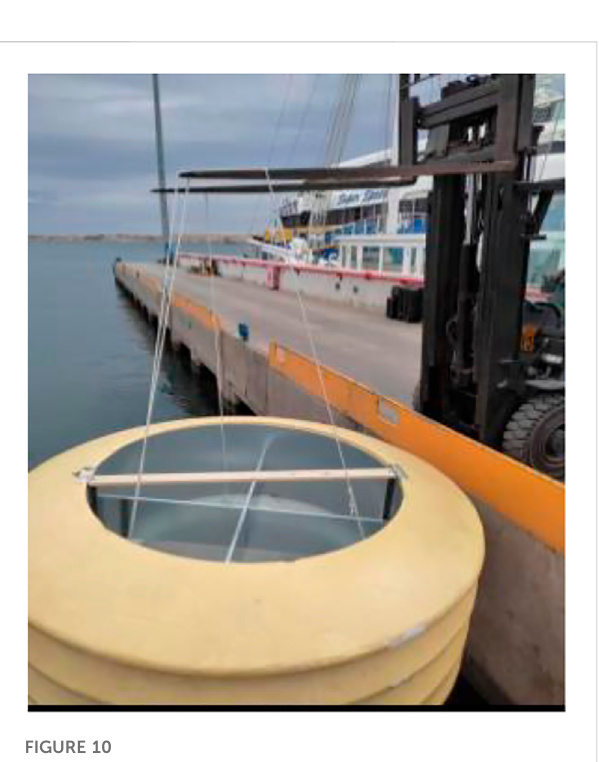
FIGURE 10 Sinking fl